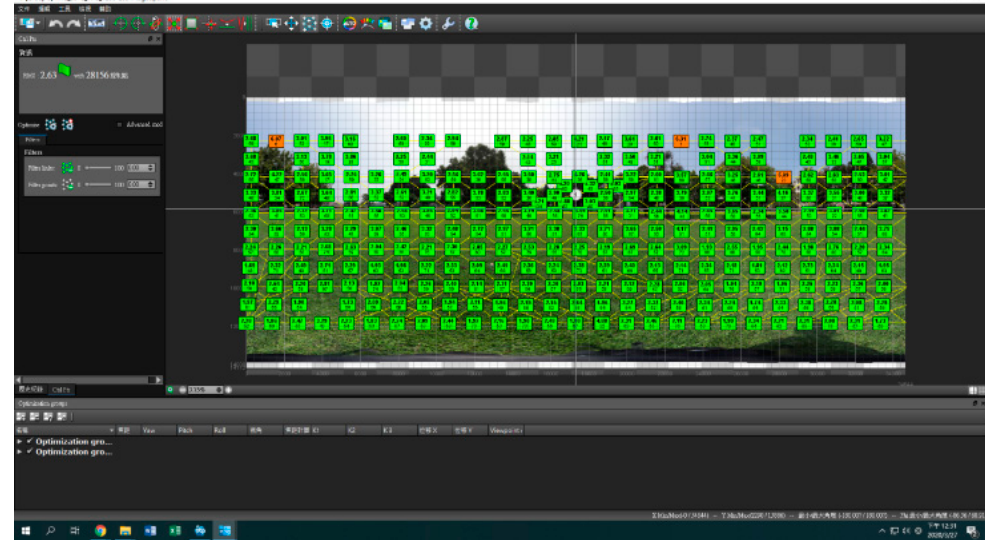
Figure 6. An example of image stitching with root mean square errors (RMSEs) where green color represents excellent results.